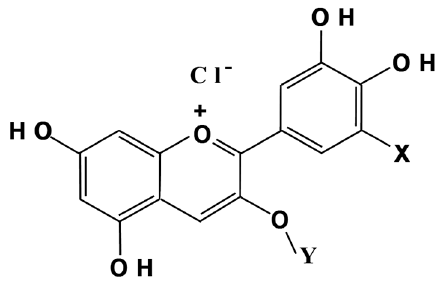
Figure 1. Structure of anthocyanin in blackcurrants. The chemical structure of each of the four anthocyanins (ACs) is as follows: D3R (X = OH, Y = glucosylrhamnose), D3G (X = OH, Y = glucose), C3R (X = H, Y = glucosylrhamnose) and C3G (X = H, Y = glucose).